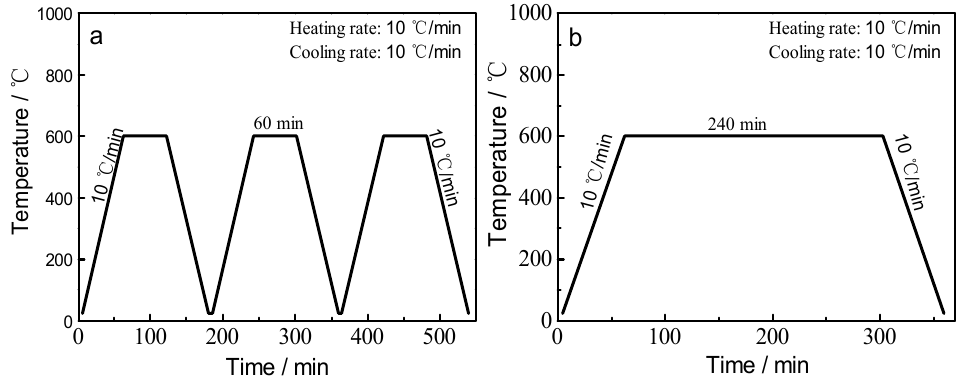
Figure 2. Heat treatment process: ( a ) tempering; and ( b ) kept at 600 °C for 4 h.